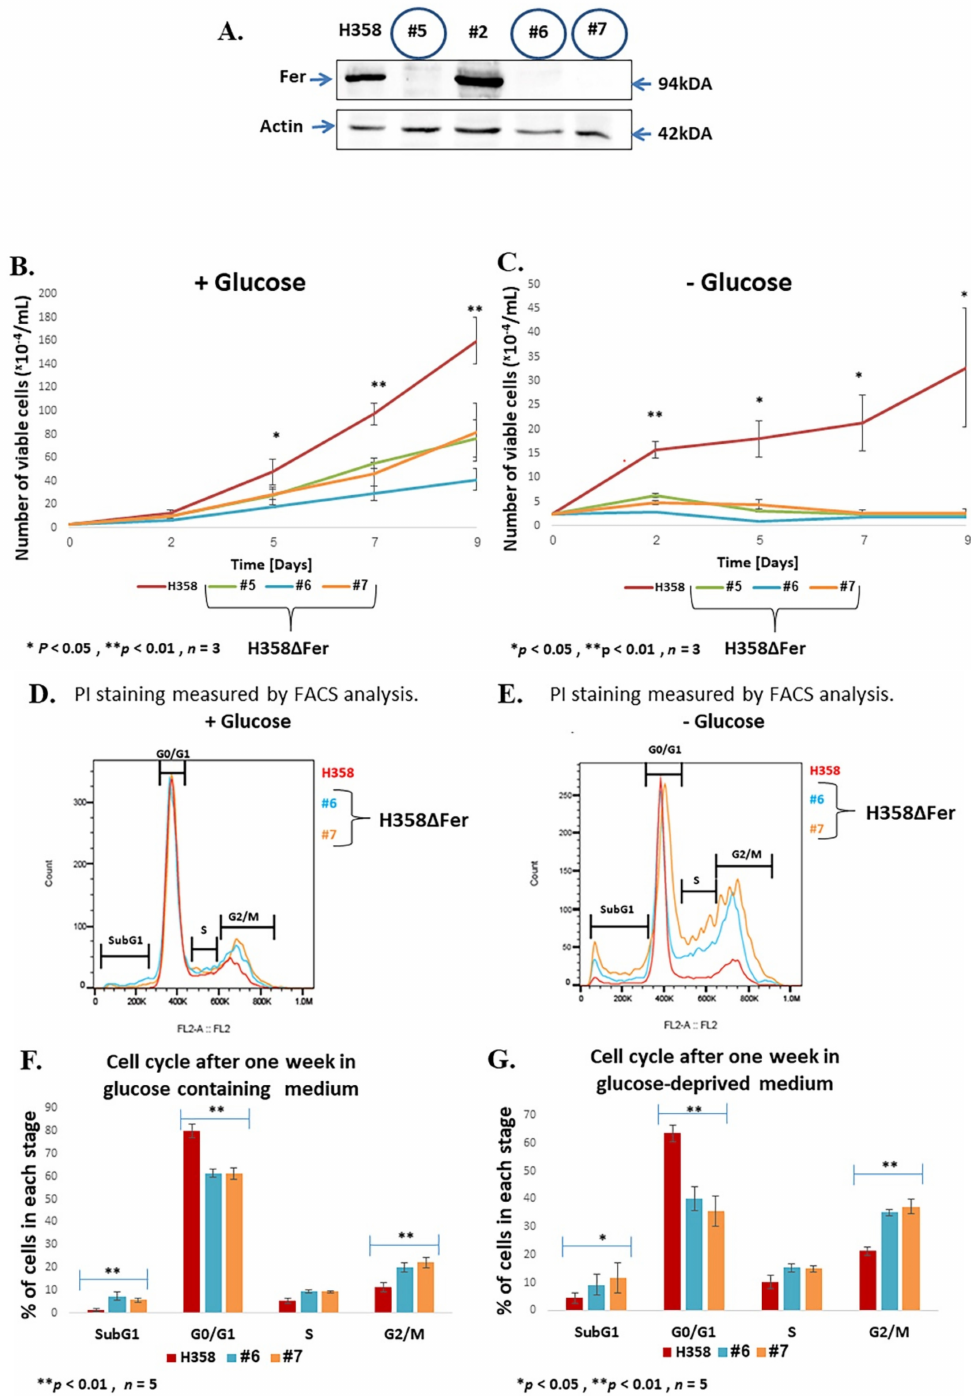
Figure 1. Impaired metabolic plasticity of Fer-deficient H358 ∆ Fer cells. ( A ) Western blot analysis of protein lysates prepared from H358 variants. H358 denotes the parental cells and clones #5, #6 and #7 are CRISPR-Cas9-established H358 ∆ Fer clones. Actin served as a loading control. ( B ) Growth curves of cells grown in a medium containing both glucose and glutamine or ( C ) in a glucose-free medium supplemented with glutamine. Values shown represent means +/ − standard error (SE) ( n = 3). ( D ) Propidium iodide (PI) staining and flow-cytometry cell-cycle analysis of cells grown in a medium supplemented with glucose and glutamine or ( E ) with glutamine alone. ( F , G ) Quantification of the results obtained in five independent experiments ( D , E ), respectively. Histograms represent means +/ − SE ( n = 5). ** p -value <